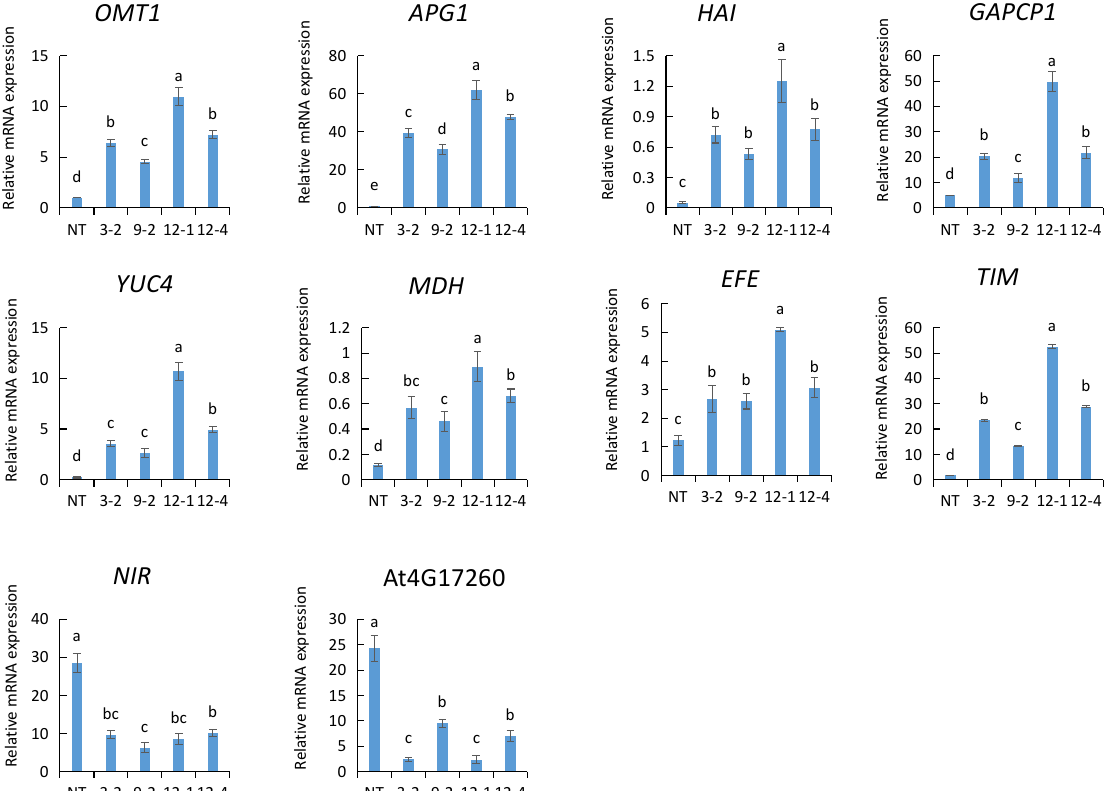
Figure 7. The expression analysis of metabolic genes in toluene treated and untreated AtNDPK2- transgenic A. pusilla . NT: non-transgenic A. pusilla plants; 3-2, 9-2, 12-1, 12-4: AtNDPK2-transgenic A. pusilla lines. Values are means of three biological repeats. Error bars indicate + SE. Different small letters indicated a significant difference ( p < 0.05, Duncan’s multiple range test).